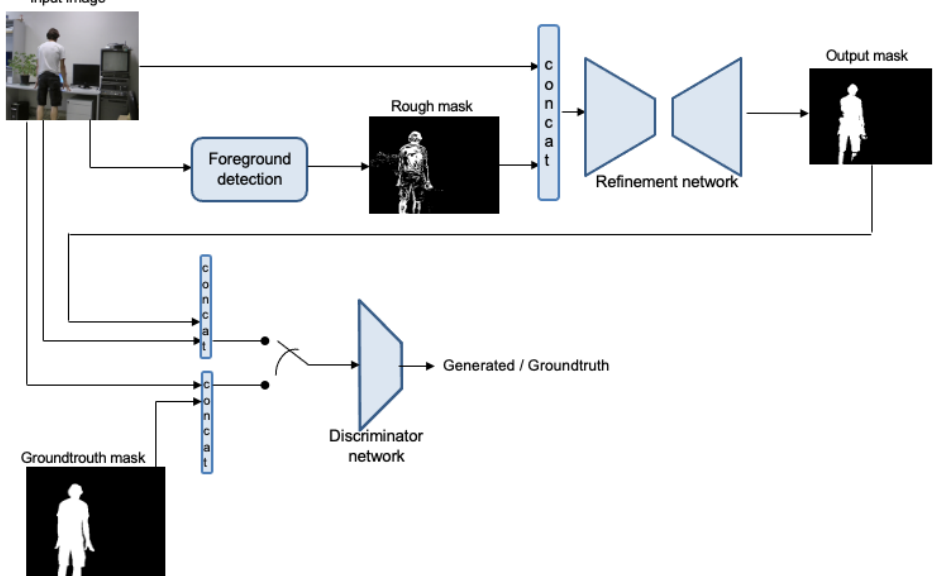
Figure 2. Pipeline of the complete scheme for training the refinement network.